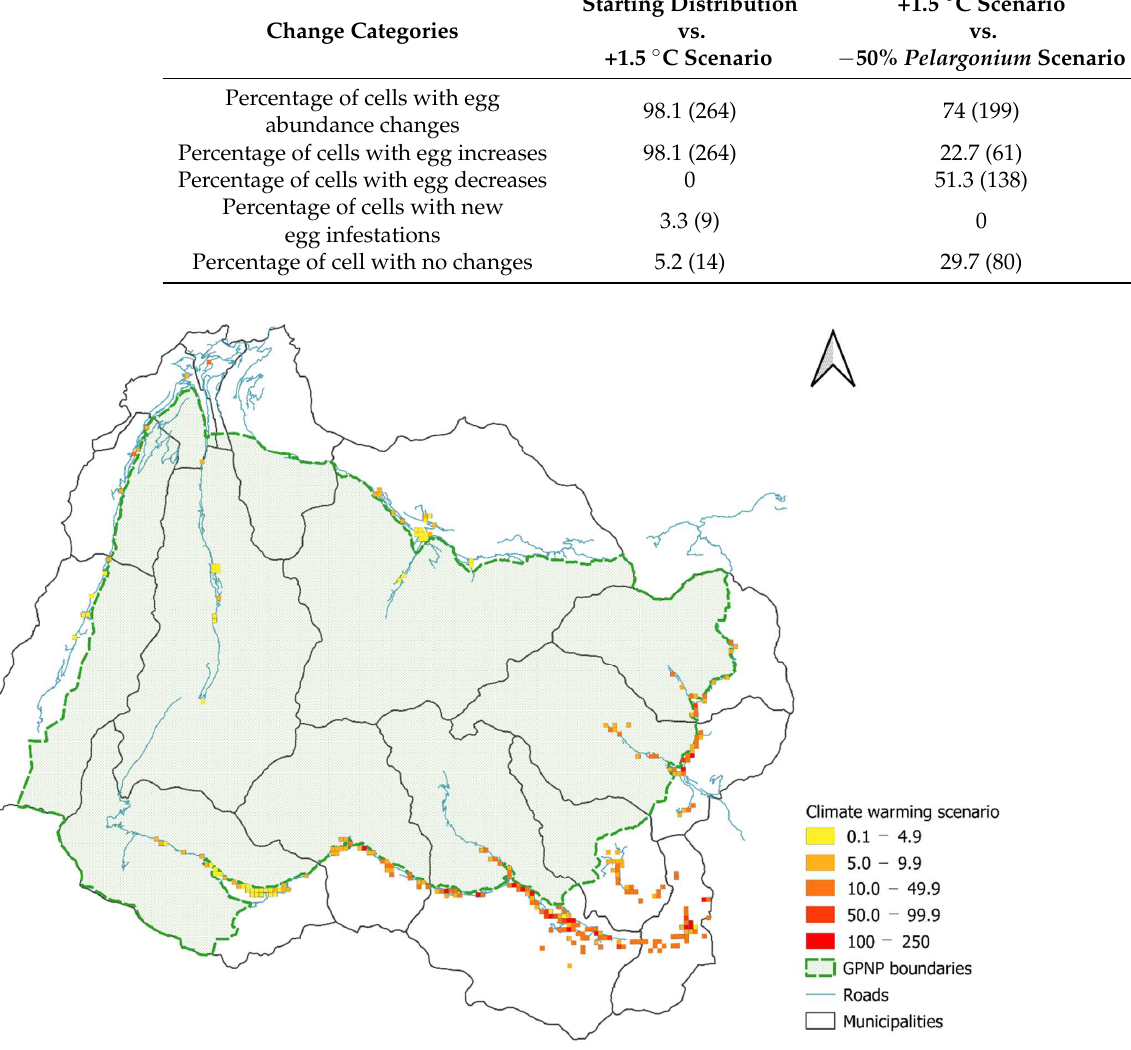
Table 4. Percentages of cells showing changes in egg abundance under different scenarios.